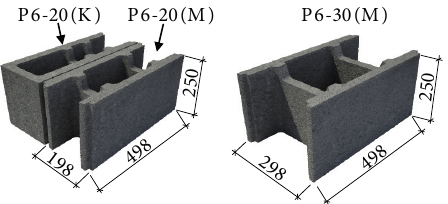
Fig. 3. Hollow concrete masonry blocks used in experimental program